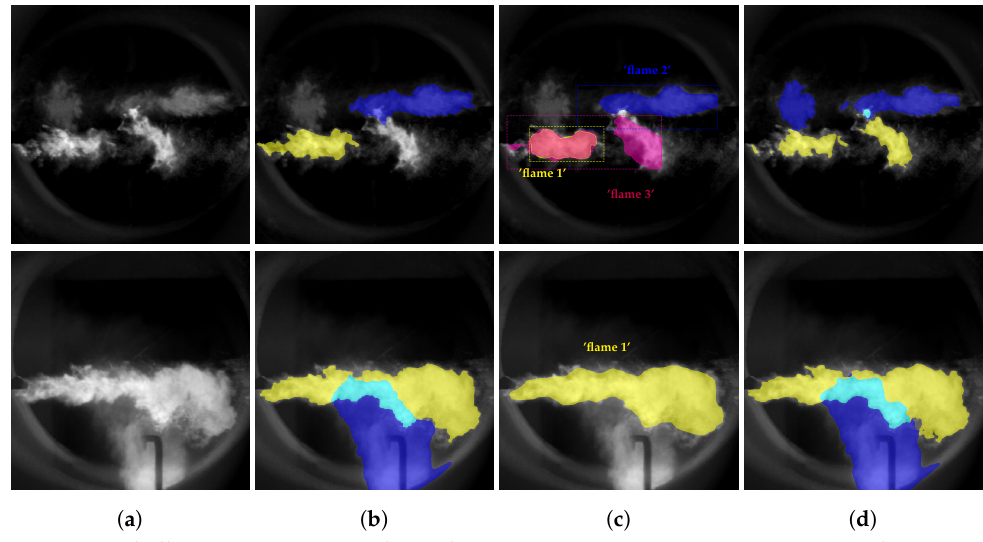
Figure 9. Challenging scenarios with Mask R-CNN in instance segmentation. ( a ) The original flame image, ( b ) the ground truth, ( c ) the segmentation inference with Mask R-CNN, and ( d ) the segmentation inference with DeepLabv3+ RN18. In the top example, Mask R-CNN detects a third flame instance (purple) on top of flame 1 (yellow, but visually adds up with purple to pink). In the bottom image, only flame 1 is detected by Mask